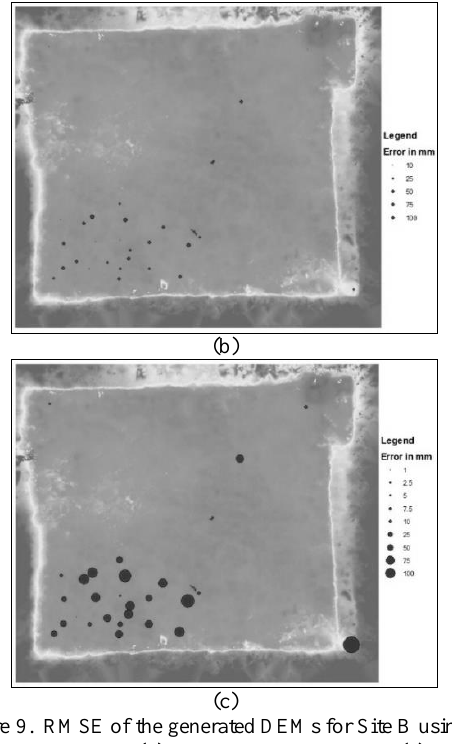
Figure 9. RMSE of the generated DEMs for Site B using (a) Nearest Neighbor; (b) Linear Interpolation; and (c) Cubic